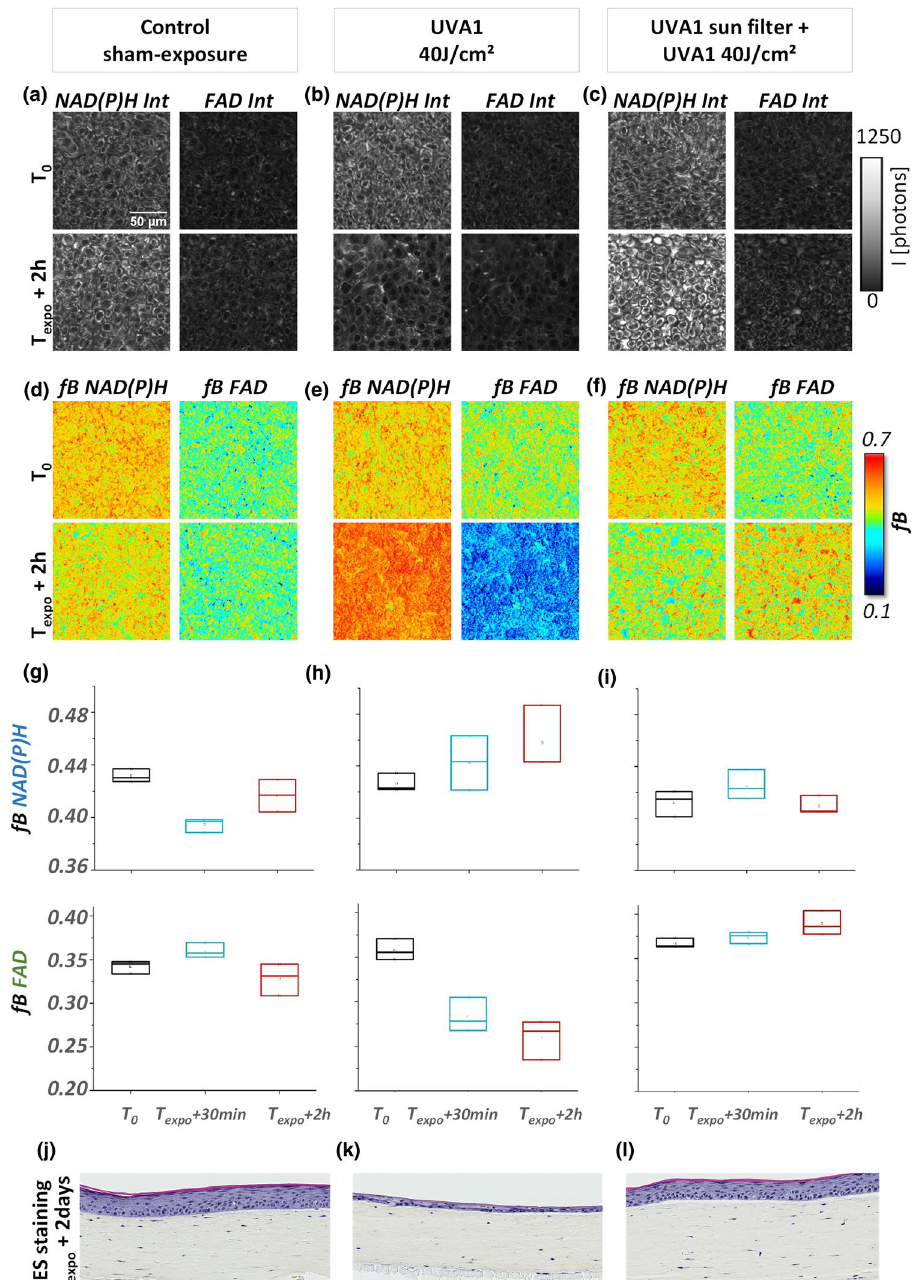
Figure 6. Effect of a long UVA filter on NAD(P)H and FAD metabolic stress response to UVA1. ( a – c ) Example of NAD(P)H and FAD fluorescence intensities and ( d – f ) fractions of bound NAD(P)H and FAD before (T 0 ) and 2 h (T expo + 2 h) post sham-exposure (Control), UVA1 40 J/cm 2 exposure in the presence and absence of a long UVA sun filter. ( g – i ) Quantification of fractions of bound NAD(P)H and FAD of the same samples at three experimental time points (T 0 , T expo + 30 min and T expo + 2 h). Data are presented as boxplots. ( j – l ) Histological HES (hematoxylin eosin saffron) analysis of the same reconstructed human skin samples imaged by FLIM, replaced in culture and fixed at 2 days post